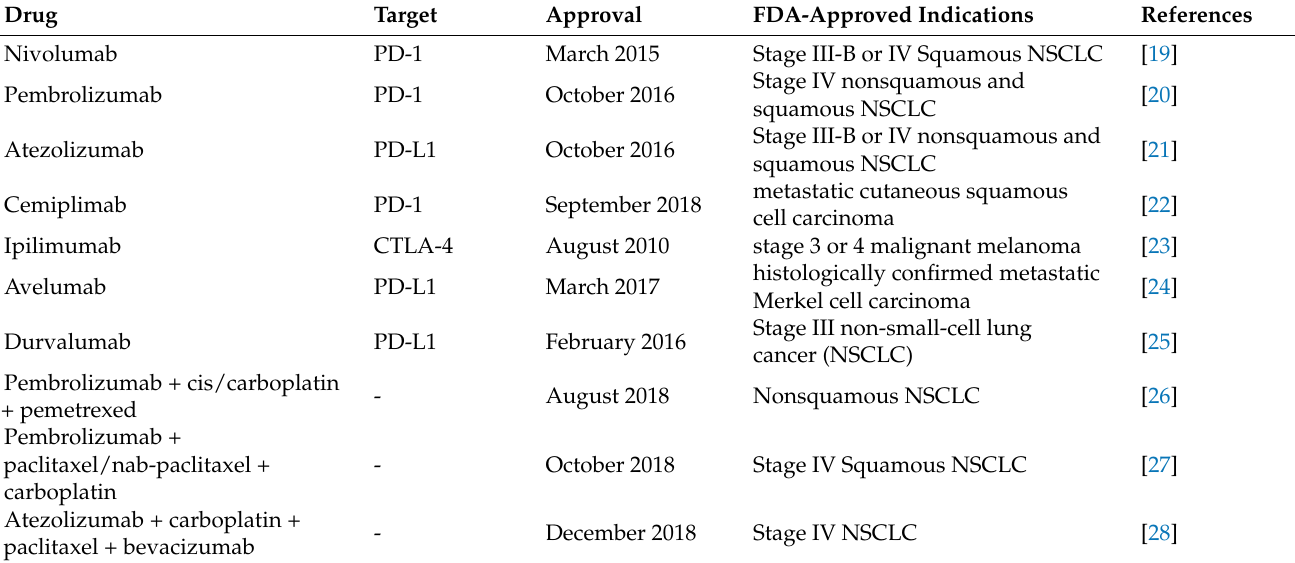
Table 1. The list of ICIs with the cancer type